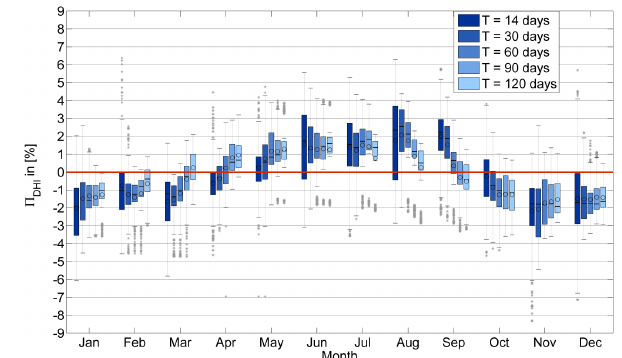
Figure 6. DLR2008: distribution of (cid:53) DHI for T = 14 days, 30 days, 60 days, 90 days and 120 days sorted by calibration starting month. (cid:53) DHI represents the deviation of calibration results from a long- term calibration for